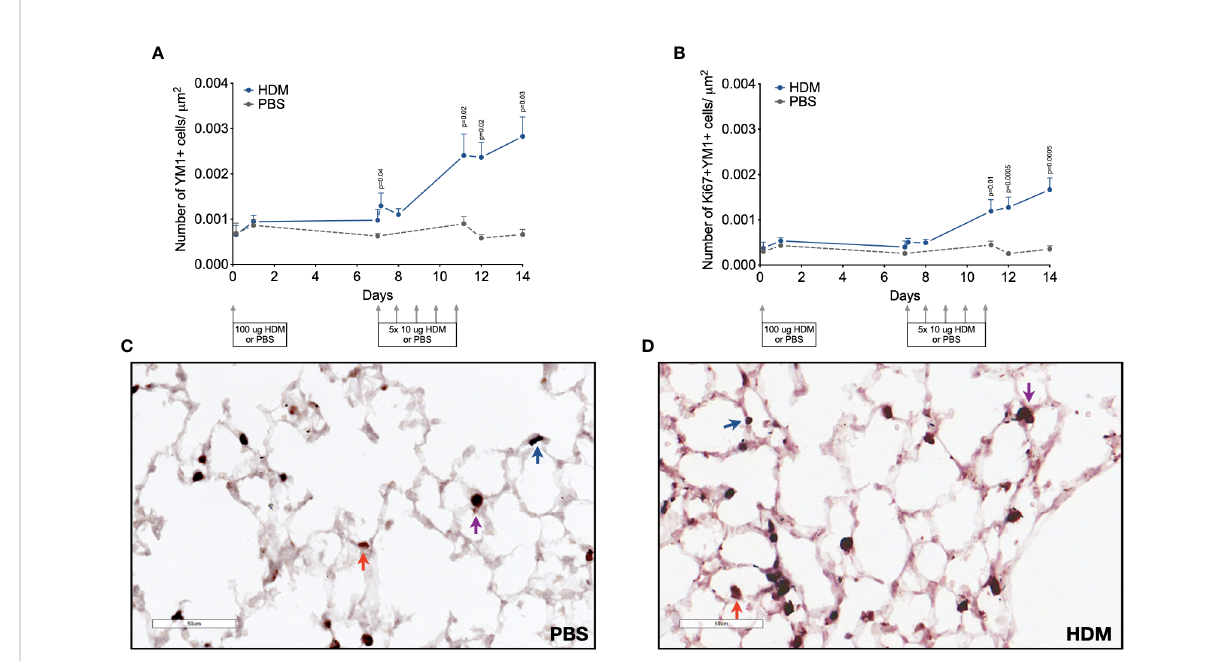
FIGURE 5 Numbers of (A) YM1+ macrophages, and (B) proliferating Ki67+ YM1+ cells in lung tissue of house dust mite (HDM)-exposed and phosphate- buffered saline (PBS)-exposed mice at different time points during exposure. The differences between HDM and PBS per time point were tested using a Student ’ s t test. Day 7.2 and day 8 of HDM were compared to day 7 of PBS with a one-way ANOVA with Sidak ’ s correction for multiple testing because these mice did not have matching PBS-exposed mice. P<0.05 was considered signi fi cant. Per time point the geometric mean and standard error of the mean per group are shown (4 males and 4 females per group, except for PBS 14 days that had 3 males and 4 females).Panels (C, D) are representative pictures of the YM1 (red) and Ki67(blue) double stainings of lung tissue of a PBS (C) and a HDM- exposed (D) mouse. Examples of YM1-single positive cells are indicated with red arrows, Ki67-single positive cells with blue arrows, and YM1/ Ki67 double positive cells with purple